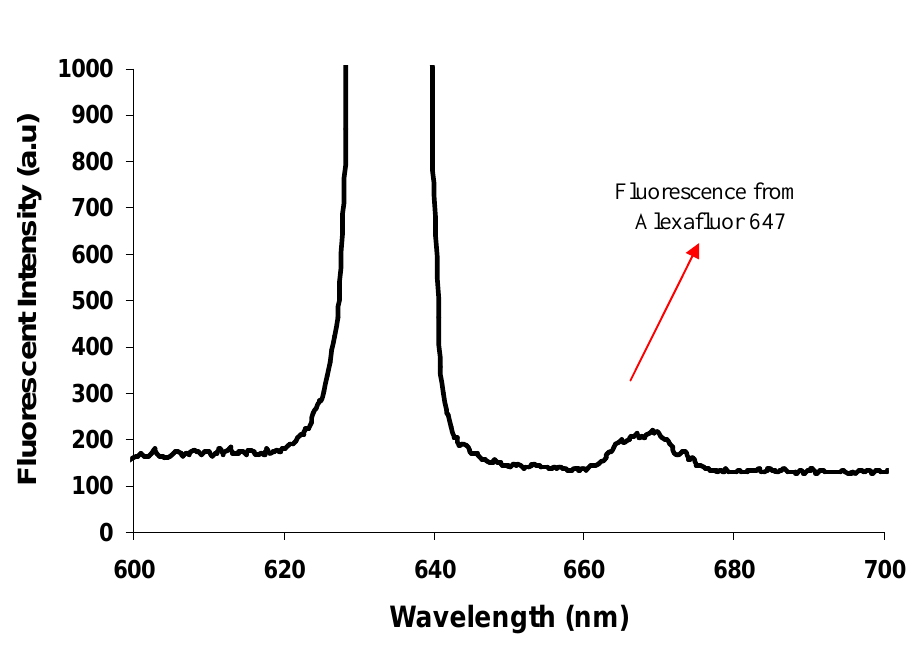
Figure 12: Fluorescence from Alexafluor 647 antibody observed at 670 nm in Channel- 11 of the